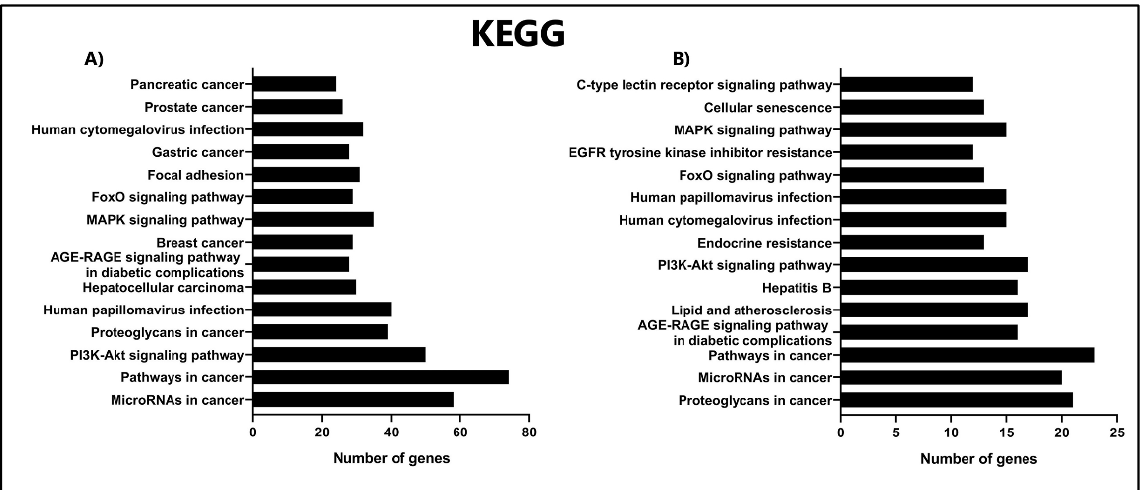
Figure 4. Kyoto Encyclopedia of Genes and Genomes (KEGG) enrichment analysis. KEGG pathway of DE-miRNAs ( A ) upregulated and ( B ) downregulated. The x -axis indicates the number of target genes, and the y -axis shows pathway names.